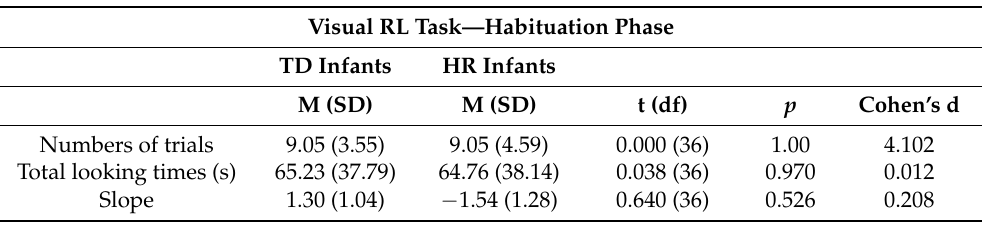
Table 4. Descriptive statistics and t -test results comparing habituation performance (i.e., number of trials, total looking times, and slope) between TD and HR infants. Visual RL Task—Habituation Phase TD Infants HR Infants M